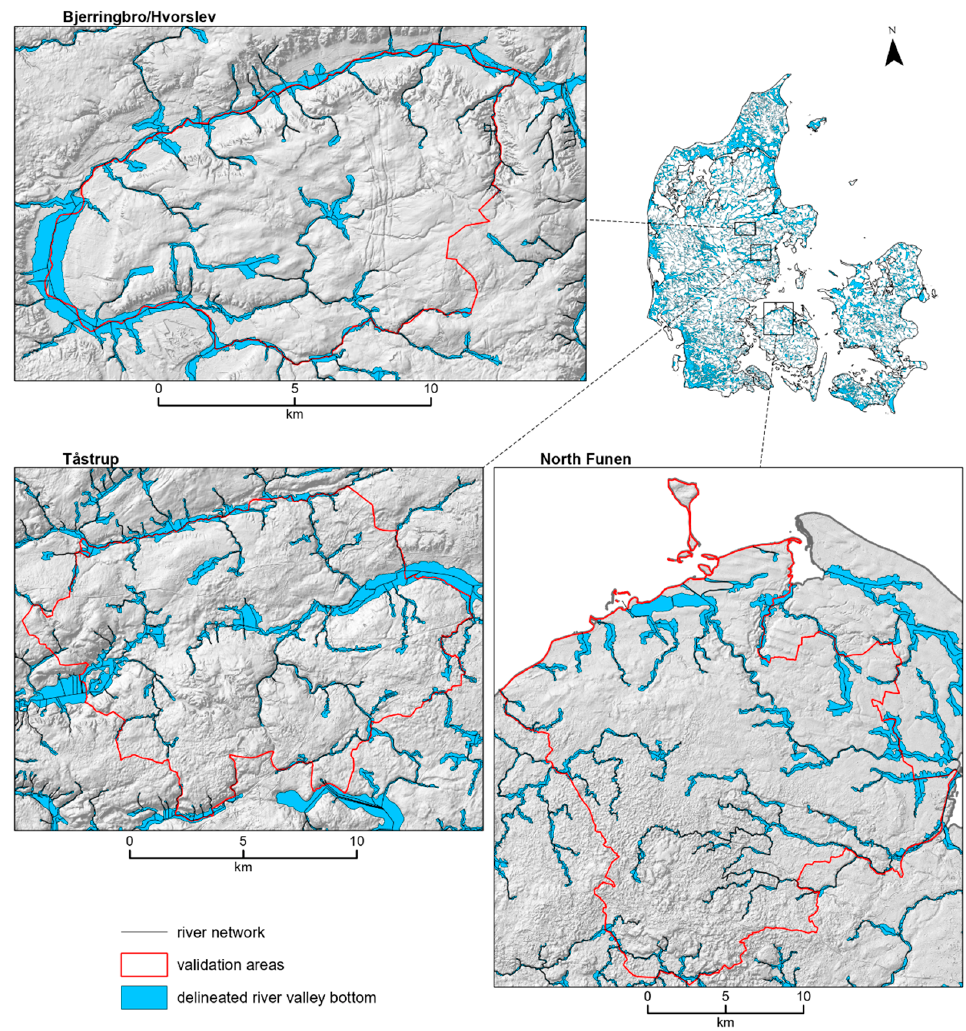
Figure 10. Delineated river valley bottom map of Denmark zoomed into the three validation areas. Confined headwater valleys have small widths, whereas unconfined downstream valleys have broader widths.